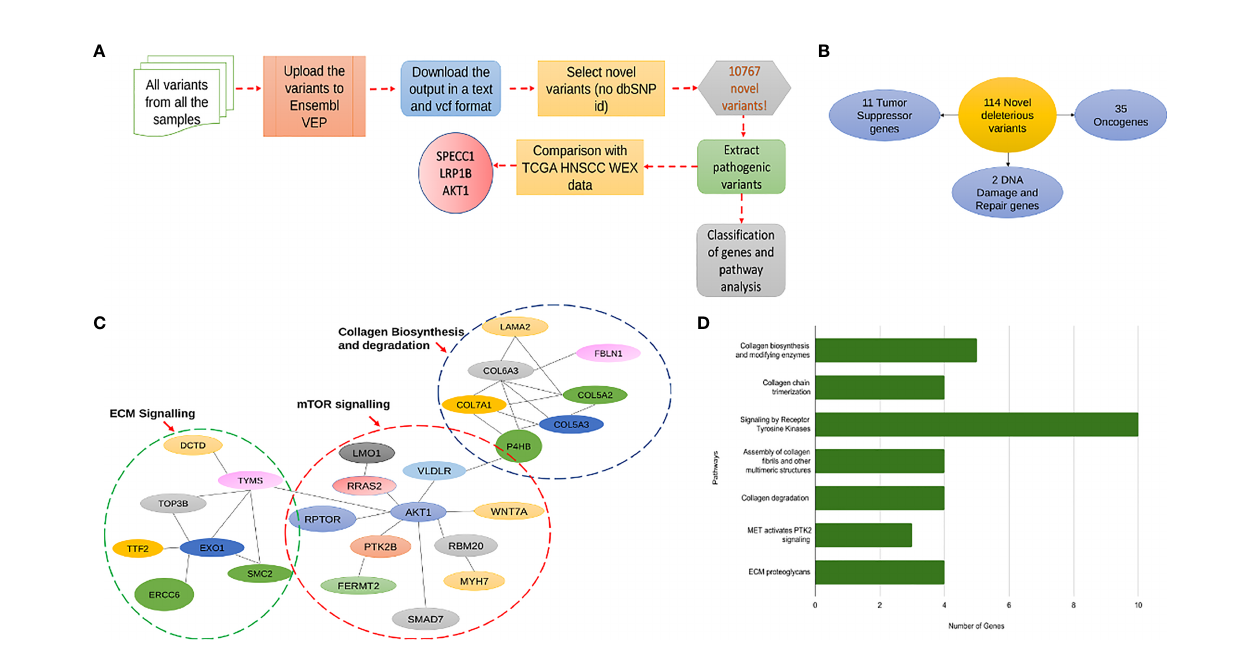
FIGURE 8 | (A) A fl owchart explaining the pipeline followed for prediction of novel deleterious variants from in-house data. (B) This diagram shows the classi fi cation of 114 novel deleterious variants into 11 Tumor suppressor genes, 35 oncogenes and 2 DNA damage and Repair genes. (C) This fi gure shows the distribution of the 114 novel deleterious variants into 3 signi fi cant pathway interaction networks, namely Collagen Biosynthesis and Degradation, mTOR signaling and ECM Signaling. (D) A bar graph showing all the signi fi cantly mutated pathways by the number of genes mutated with the most signi fi cant pathway being receptor tyrosine kinase